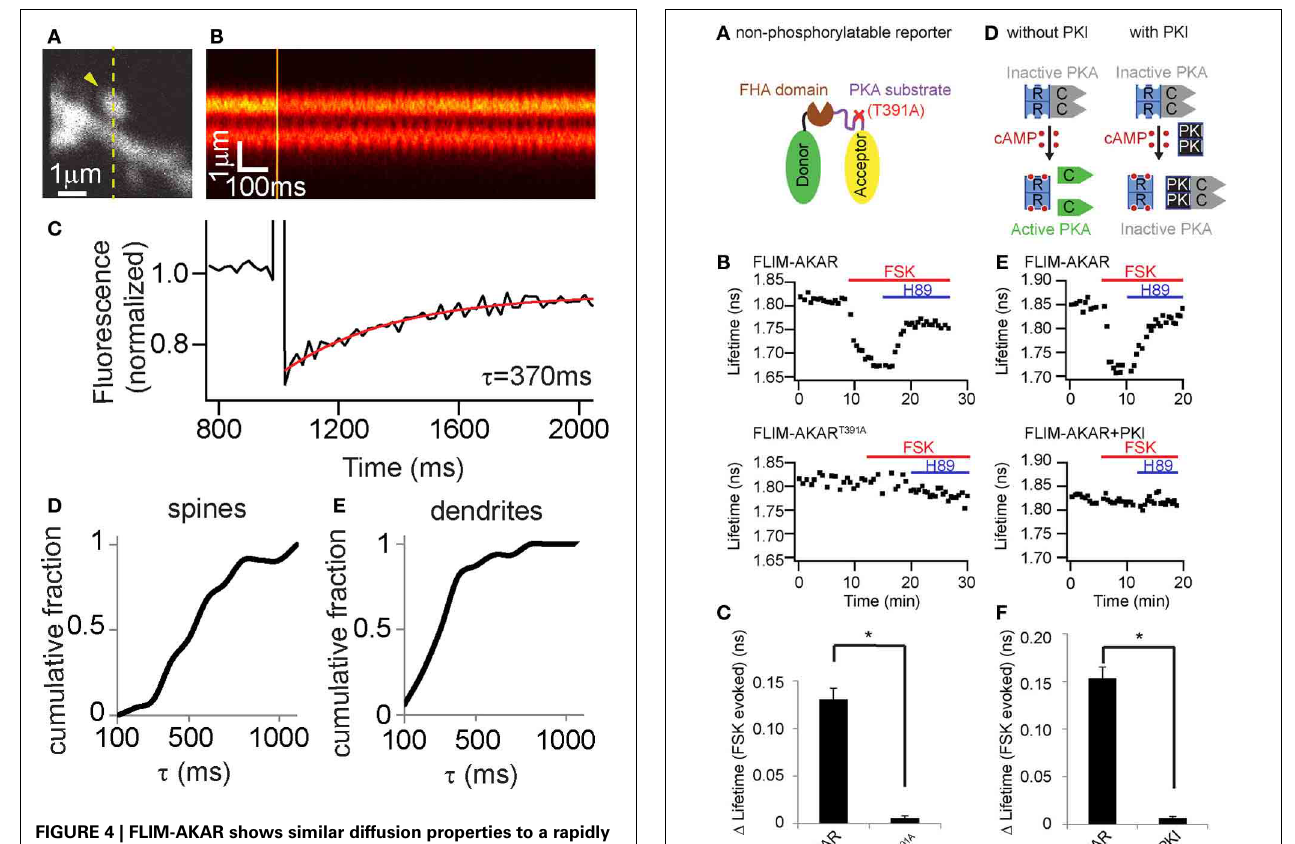
FIGURE 4 | FLIM-AKAR shows similar diffusion properties to a rapidly diffusing cytoplasmic protein. (A–E) Fluorescence Recovery After Photobleaching (FRAP) experiments to measure the spreading of FLIM-AKAR. (A) Image of FLIM-AKAR donor fluorescence of a dendritic region of a hippocampal CA1 neuron cultured in organotypic slices. The arrowhead shows the spine that was photobleached. The dashed line shows the region being imaged by line scan. (B) Fluorescence measured in line scans for the region indicated by dashed line in (A) . (C) Quantification of FRAP for the spine shown in (A,B) . The trace was an average of 4 acquisitions. The red trace shows curve fitting with a single exponential decay. (D,E) Cumulative distribution of τ from FRAP experiments to examine FLIM-AKAR spreading from spines (D) and for aspiny regions of dendrites (E) in hippocampal CA1 neurons.